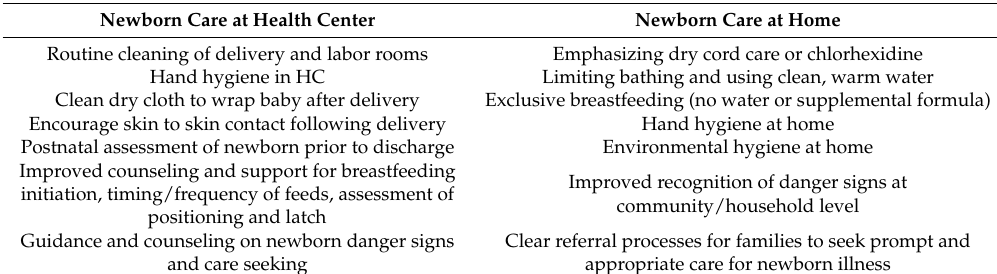
Table 2. Recommended areas for